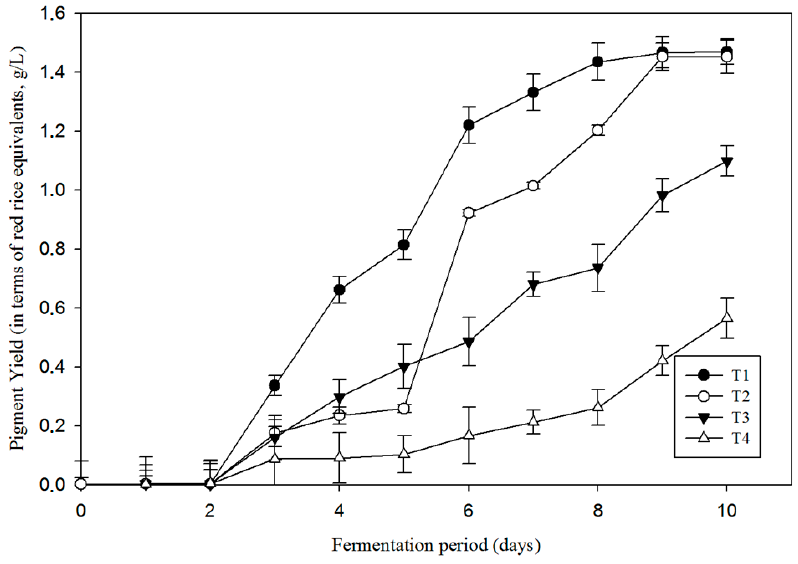
Figure 4. Effect of salt concentration (0% (T1), 3.65% (T2), 6% (T3), 9% (T4)) on pigment yield in T. albobiverticillius 30548 (expressed in Monascus red rice equivalents g/L, measured at 500 nm) (culture in PDB, 27 °C, initial pH 4.0, 200 rpm of agitation rate). Table 4. Rate of pigment production and final pigment yield from T. albobiverticillius 30548 based on salinity percentage in the fermentation media (culture in PDB, 27 ◦ C, initial pH 4.0, 200 rpm of agitation